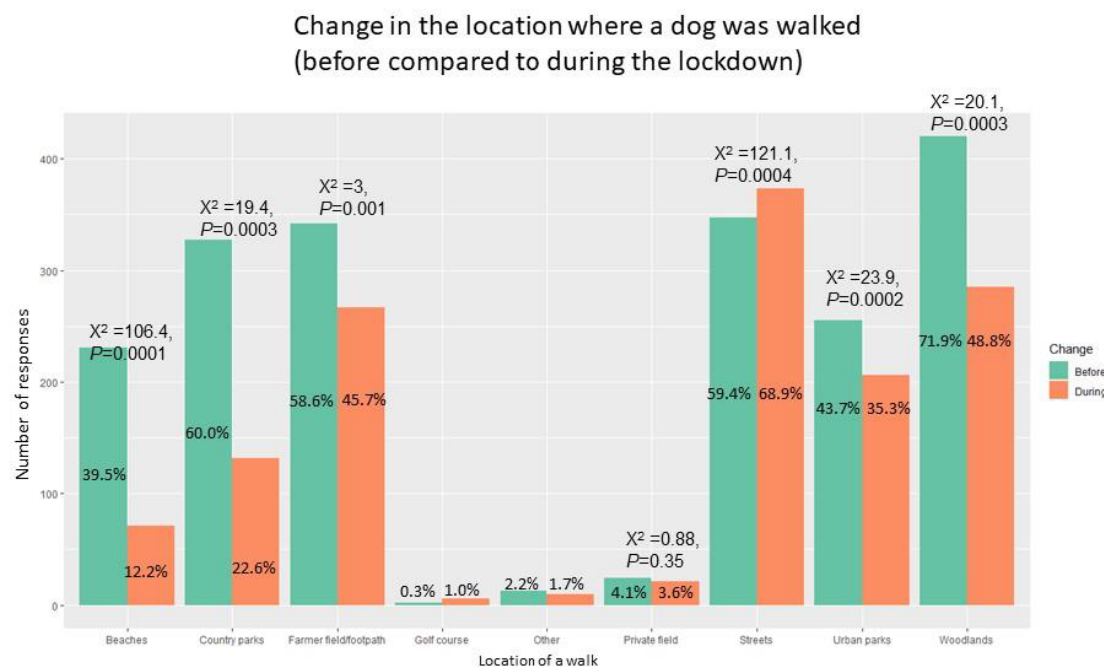
Figure 3. Walking location before and during the pandemic lockdown (McNemar’s X 2 and p -value are provided where the sample size permitted a meaningful comparison).